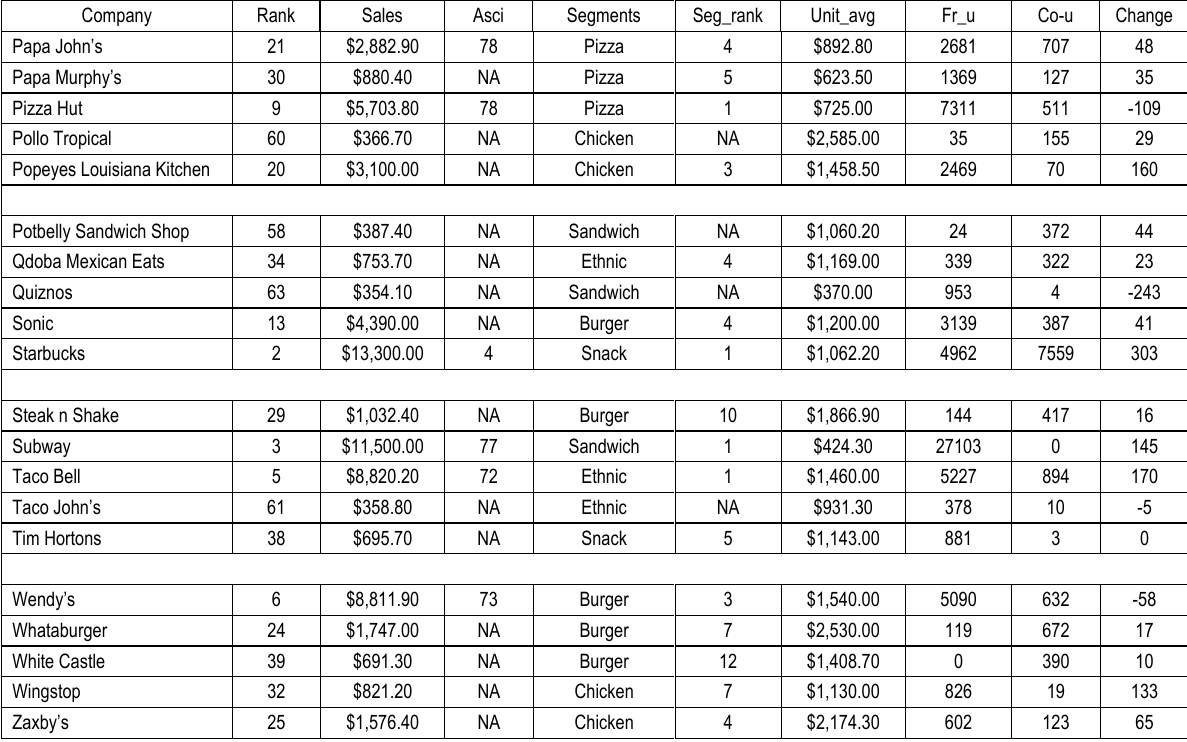
Table 1.(cont.) Quick service restaurants (USA, 2015)